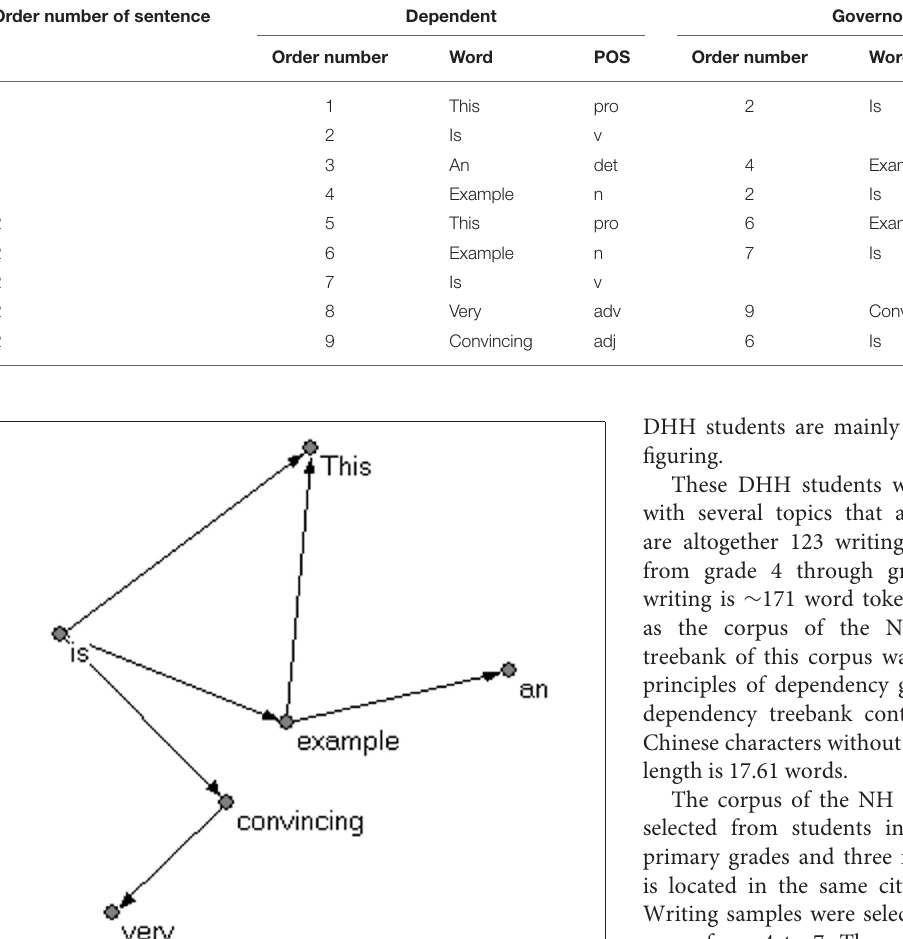
TABLE 1 | A syntactic dependency treebank based on two sentences. Order number of sentence